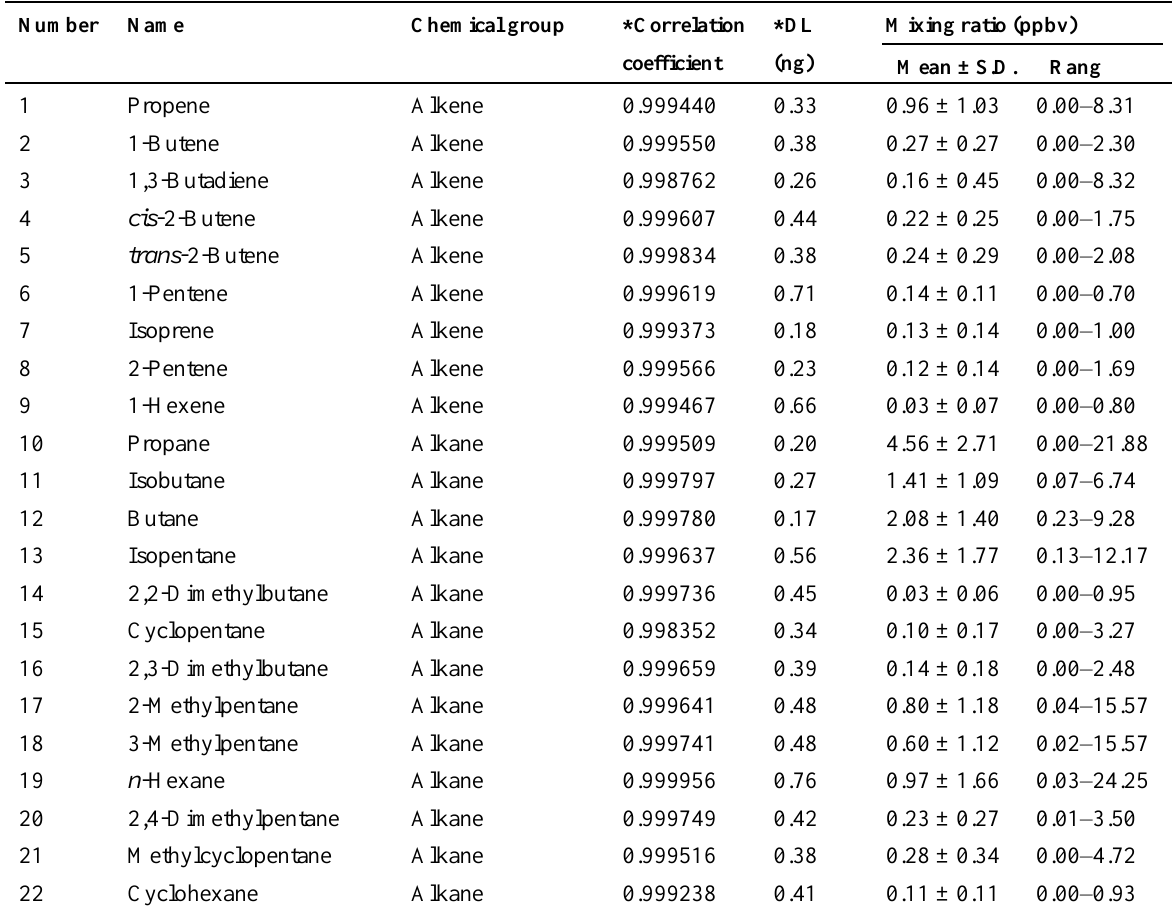
Table 1. The detailed information of measured VOC in the Xujiahui site averaged from 2006 to 2010 (495 air